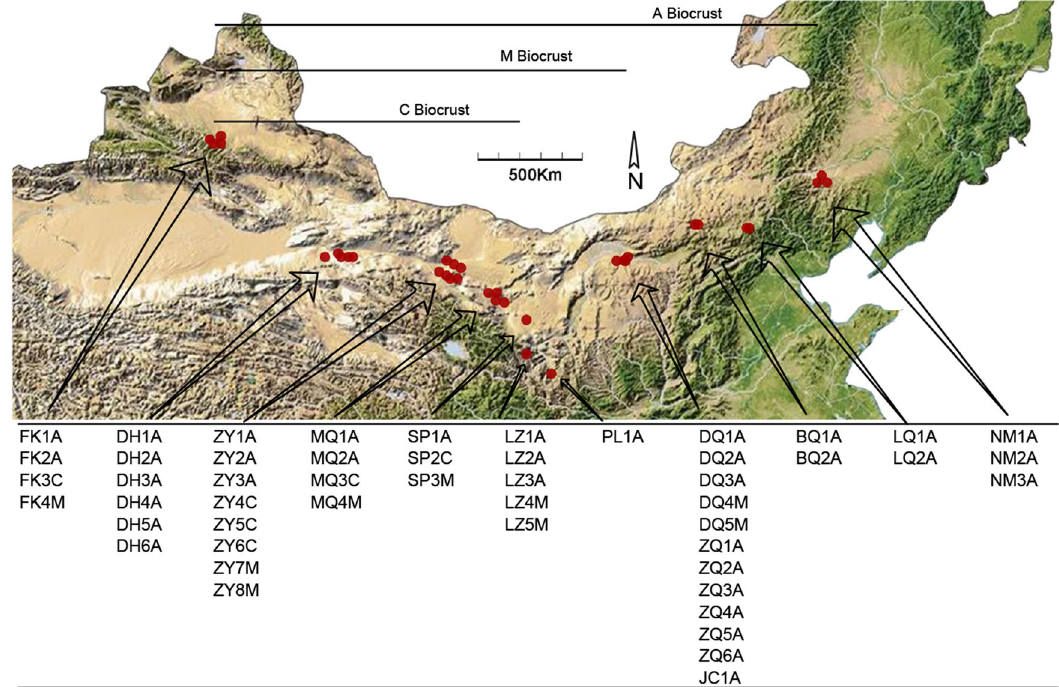
Fig. 5 Study area and sampling sites of north China. The biocrusts were sampled and showed in geomorphic map. There were 35 algae- dominated (A) crust sites, 6 lichen-dominated (C) crust sites, and 9 moss-dominated (M) crust sites shown in the fi gure, and four parallel samples were collected in each sample site. The black horizontal line indicates the geographical span of each biocrust type. Sample site naming rules: the fi rst two letters and the last letter represented place names and biocrust types, respectively. This map is free to use and could be acquired from BIGEMAP (http://www.bigemap.com) and open source geospatial data cloud (http://www.gscloud.cn). And it also is available from the corresponding author on reasonable